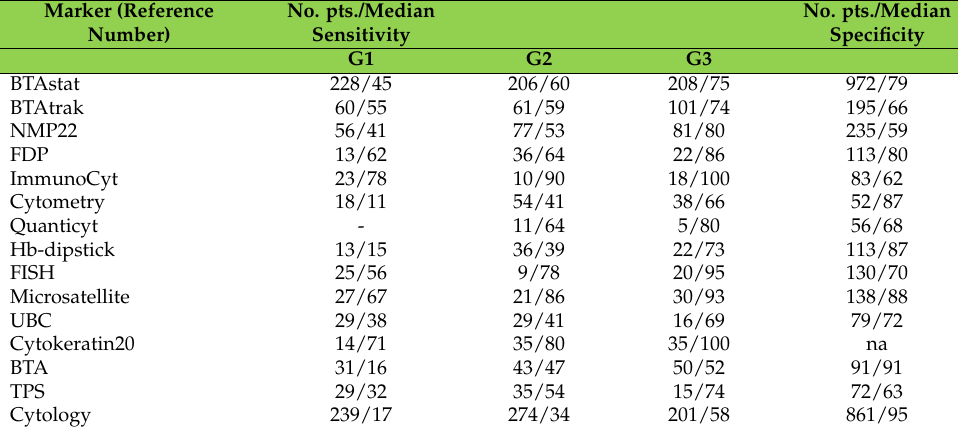
Table 3. The median sensitivity per grade (G1–3) and specificity of the urinary biomarkers for surveillance of recurrent bladder cancer. Adapted from van Rhijn et al.